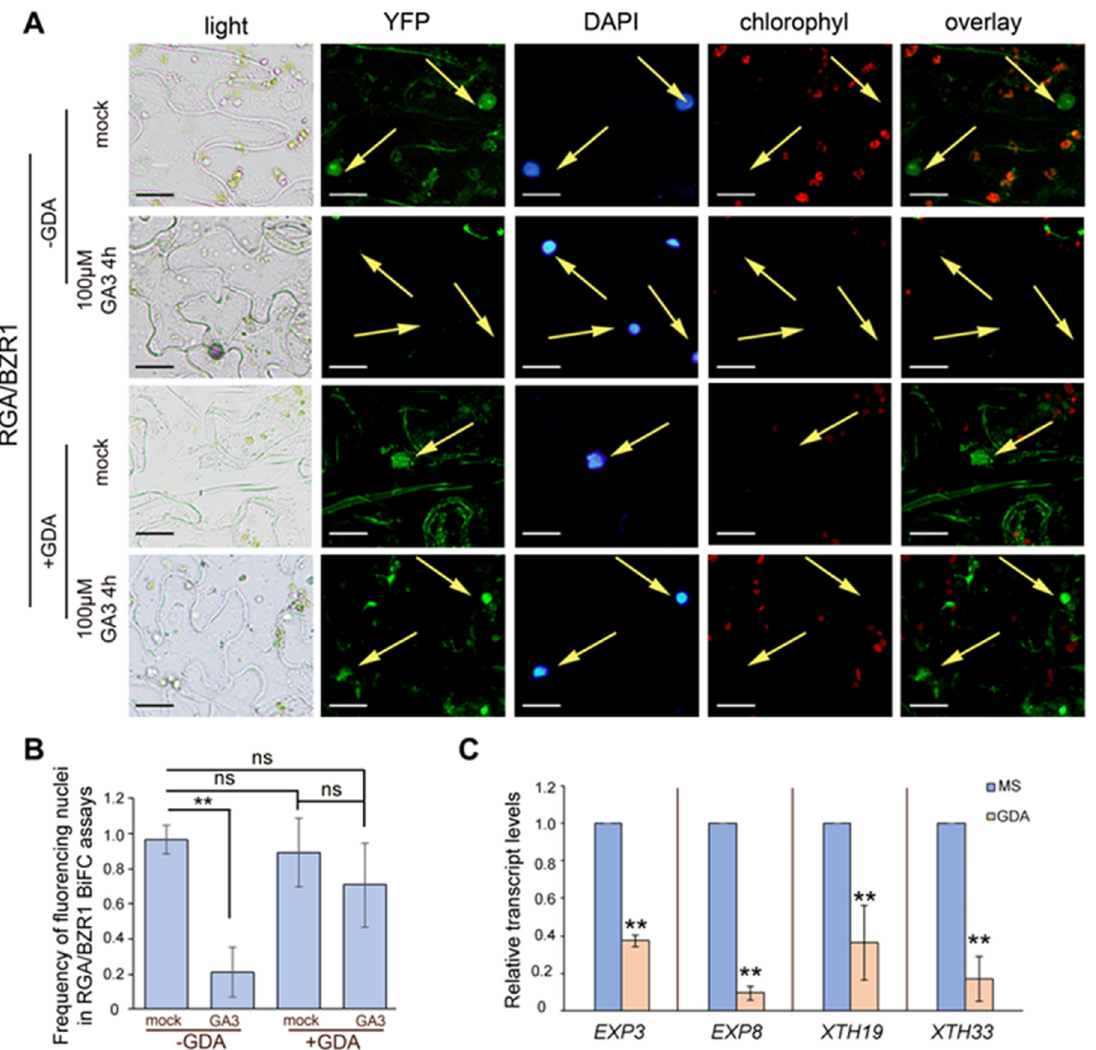
Figure 6. GA-promoted BZR1 transcriptional activity depends on HSP90-mediated RGA inactivation. ( A ) BiFC assays to test the interaction of RGA with BZR1 in N. benthamiana leaf epidermal cells. Tobacco leaves co-transformed with RGA-YFPc and BZR1-nYFP constructs were treated with 100 µ M GA 3 for 4 h or with 10 µ M GDA for 12 h or with 10 µ M GDA for 8 h followed by treatments with 100 µ M GA 3 for 4 h. Arrows indicate the nuclei. Scale bars, 20 µ m. ( B ) Percentage of fluorescent nuclei after the indicated treatments in ( A ). Mean ± SD from at least 300 nuclei examined per treatment. (**): p < 0.01, ns—non-significant according to t -test. ( C ) Relative transcript levels of BES1/BZR1 target genes in 5-day-old etiolated seedlings of wild-type, hsp90.1 and hsp90.2 mutants under control conditions or in the presence of 2 μ M GDA for 4 h. GAPDH was used as a reference gene. Data are means, and error bars indicate ± S.D. (**): p < 0.01, ns—non-significant according to t -test.